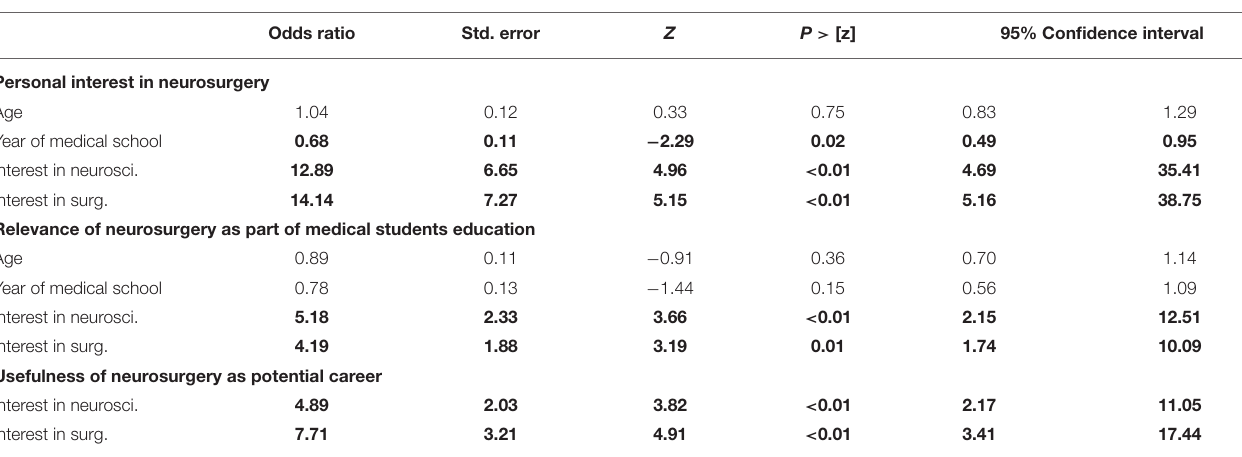
TABLE 8 | Results of multivariate statistical analysis. Odds ratio Std.